Question: What visual encoding does this figure use to show its data?
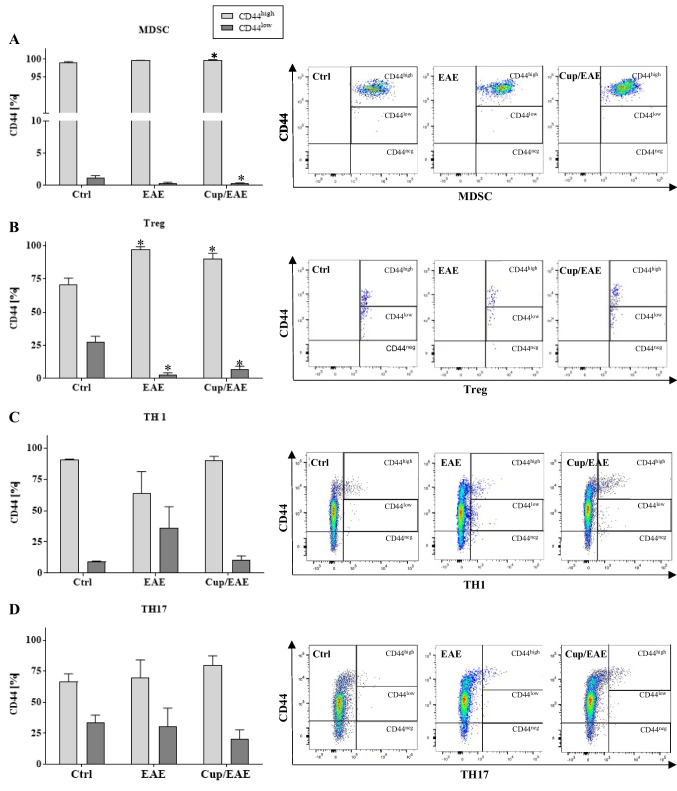
Answer: bar